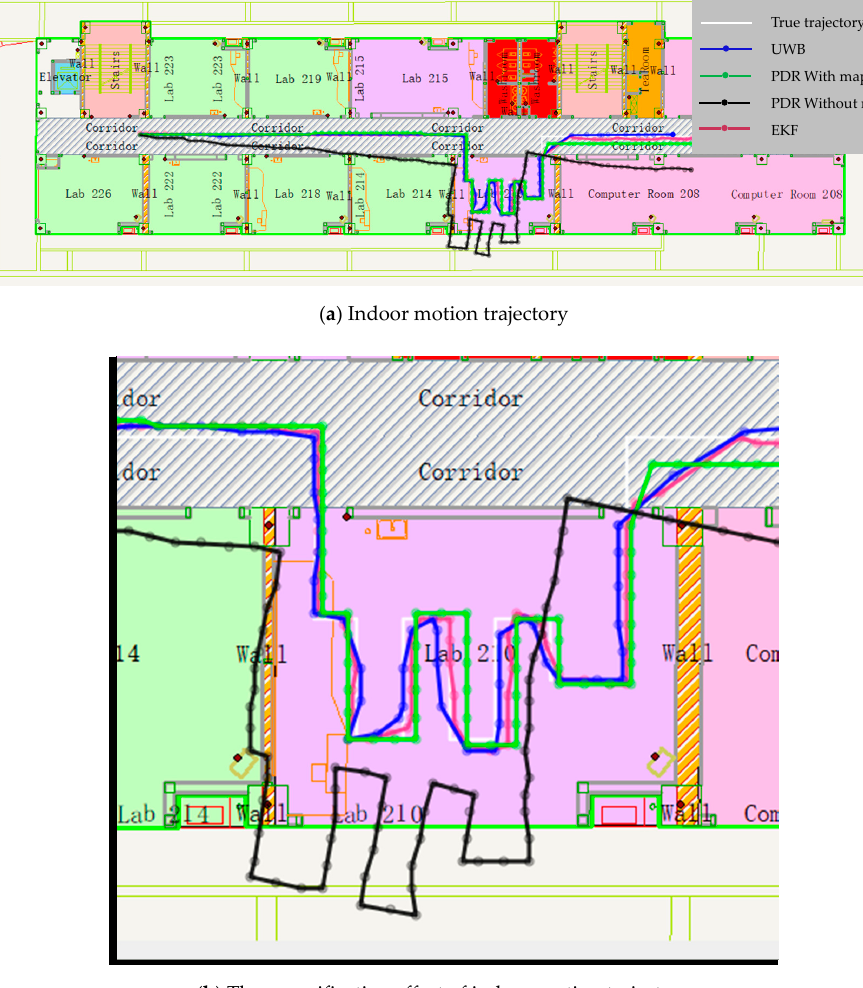
Figure 13. Pedestrian trajectory calculated with four algorithms.